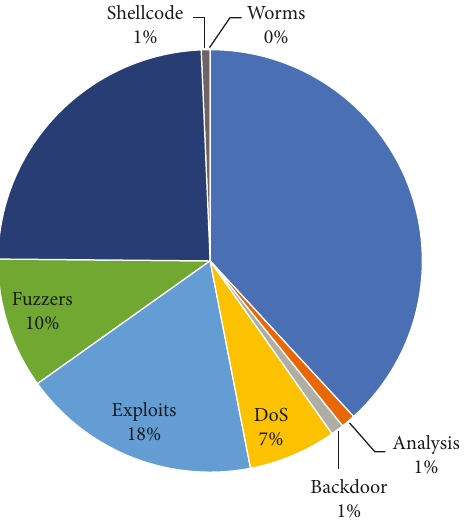
Figure 1: Pie chart of UNSW-NB15 dataset distribution.